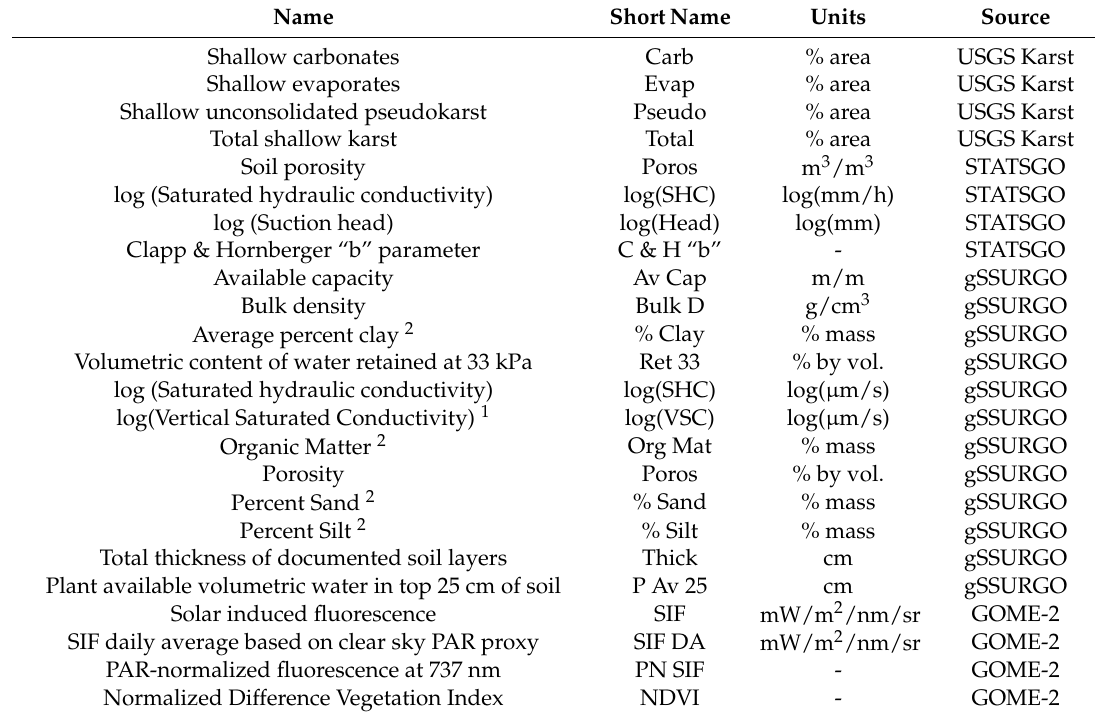
Table 1. List of land properties examined in this